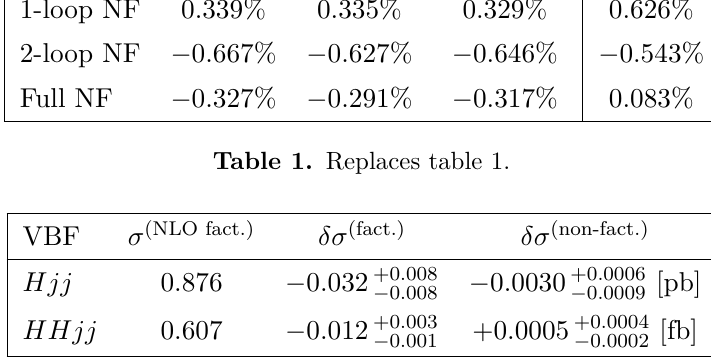
Table 2. Replaces table